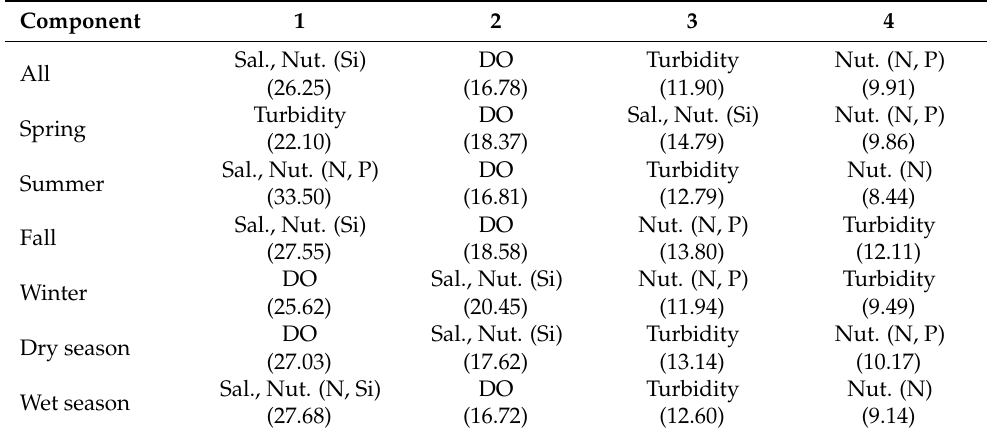
Table 4. Principal components and total variance explained (%). Sal.: salinity; Nut.: nutrient; DO: dissolved oxygen; N: nitrogen-based nutrients; P: phosphate; Si: silicon.